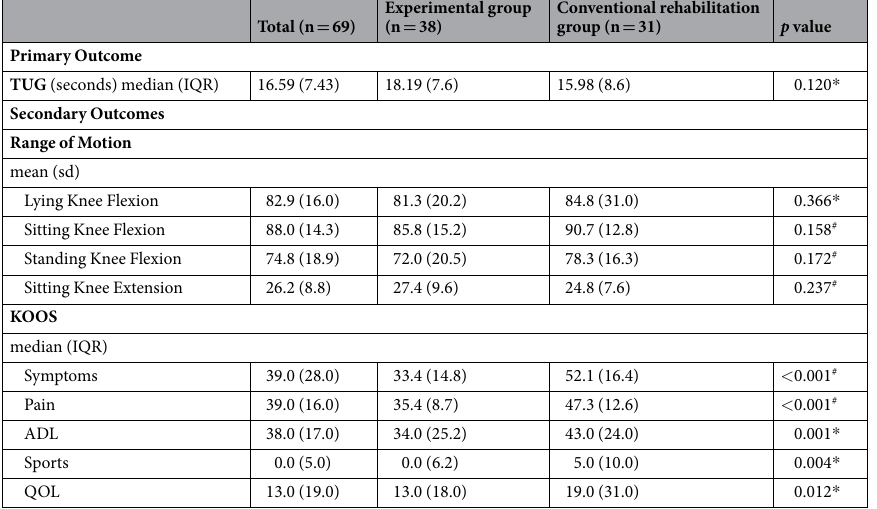
Table 2. Pre-operative assessment of outcome measures in study participants. # Independent samples T test; * Mann-Whitney U Test.